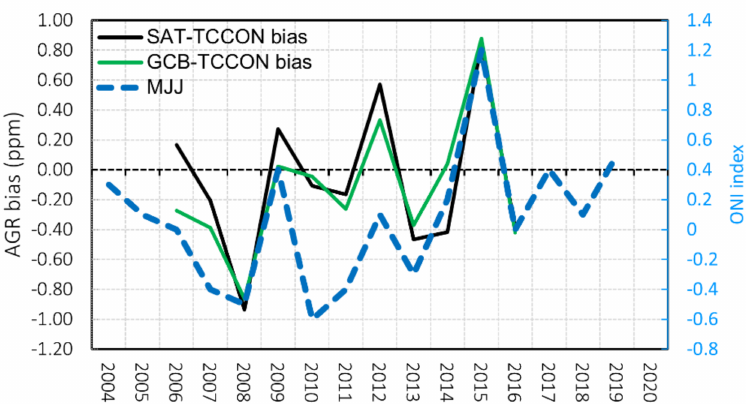
Figure 8. Time series of AGR SAT-to-TCCON bias (black solid line) and GCB-to-TCCON bias (green solid line) versus MJJ ONI (blue dashed